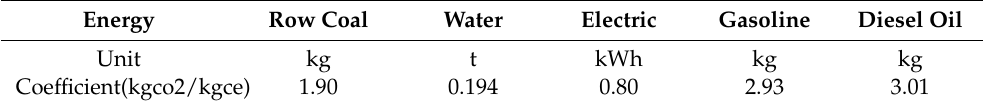
Table 4. Main energy carbon dioxide emission